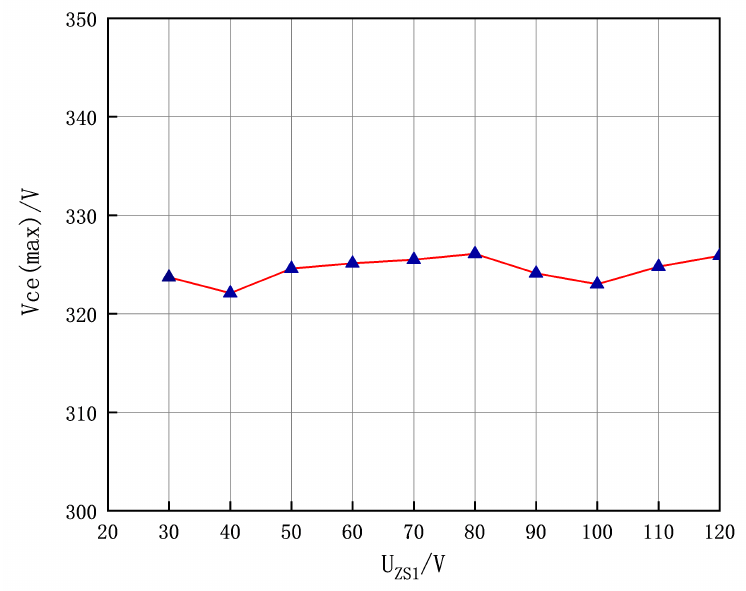
Figure 12. Curve of V ce ( max ) changing with U ZS 1